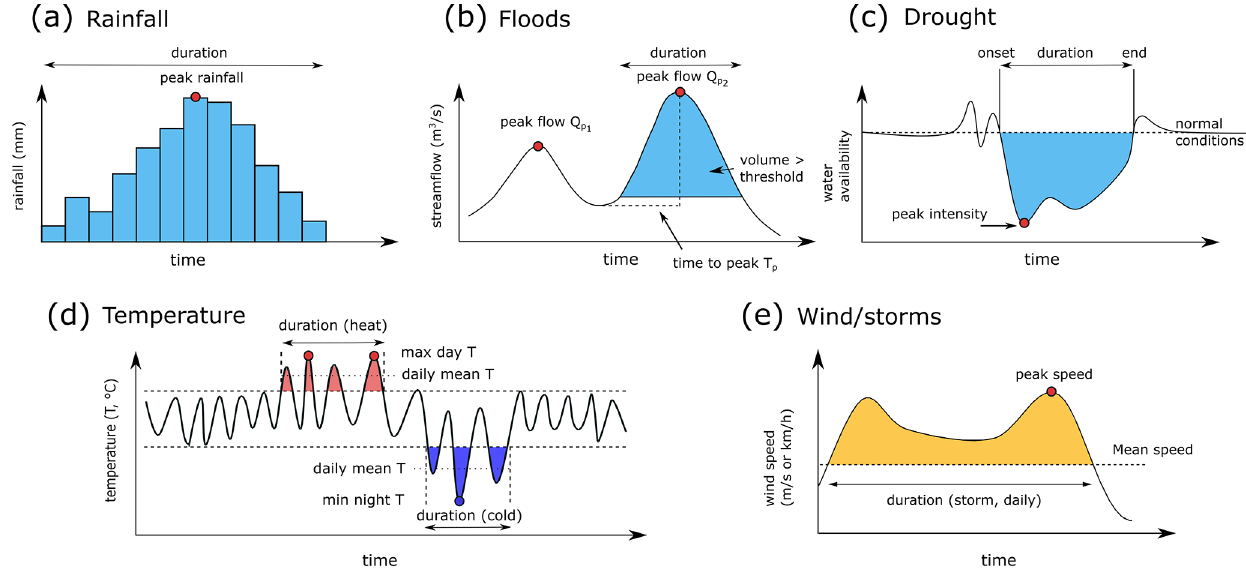
Figure 3. Metrics employed for evaluating five types of hydroclimatic extremes. (a) Precipitation hyetograph. (b) Flood hydrograph. (c) Drought. (d) Temperature. (e) Wind (storms). All these variables can be described using indicators of event duration and magnitude (peak